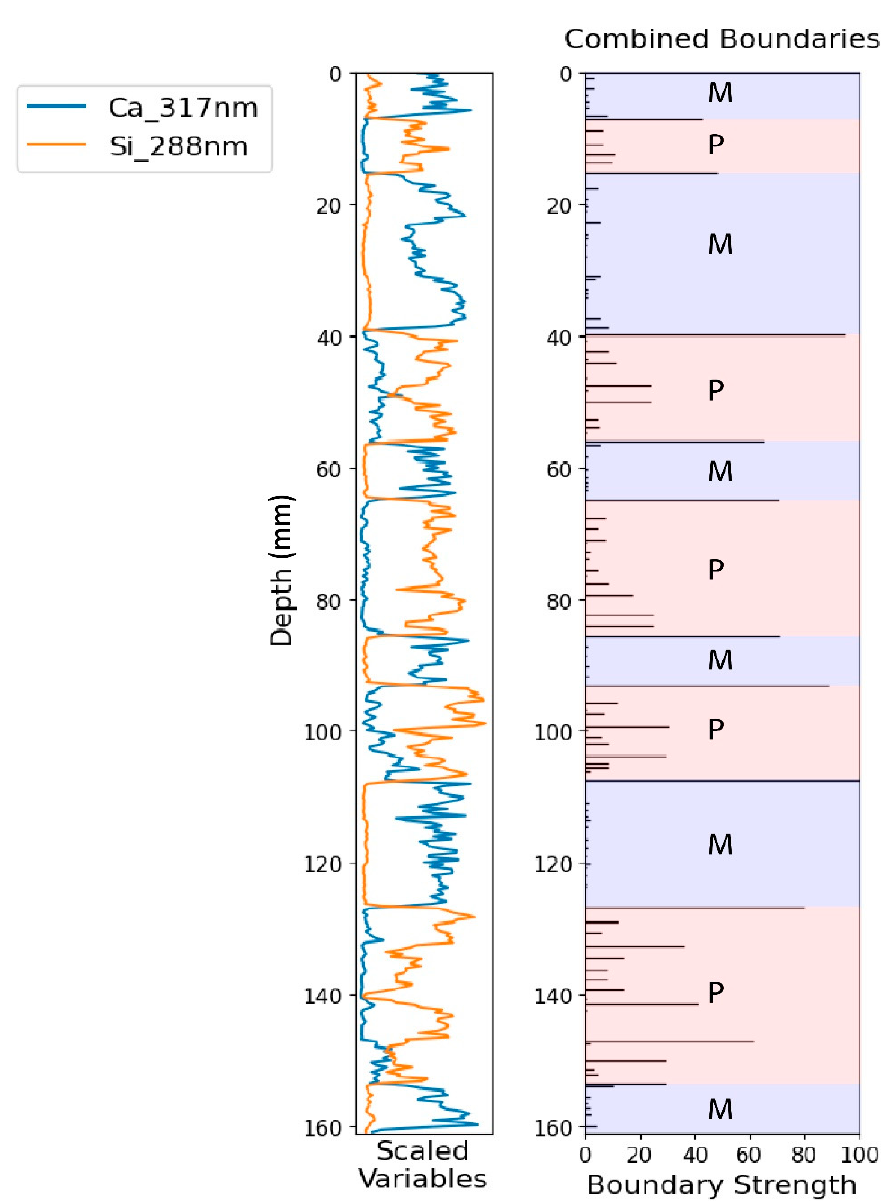
Figure 8. Ca (317 nm) and Si (288 nm) LIBS data combined boundaries generated through wavelet tessellation. Note that superimposed sharp variations on Ca and Si counts are related to the strongest boundaries (multivariate boundaries) and the presence of intraslab boundaries suggests the possibility of refined classifications, mainly relative to plutonic slabs. (M = marble, P = plutonic; classification from whole rock geochemistry data, Figure 4).